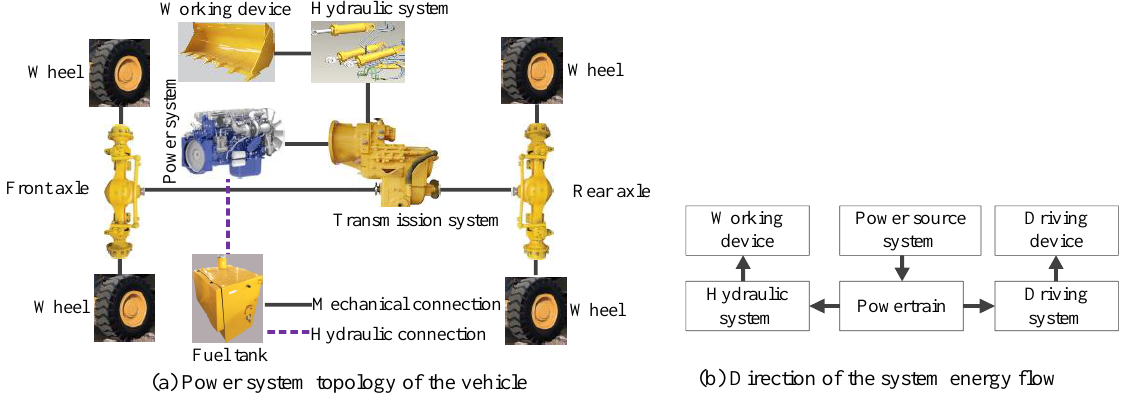
Figure 1. The drivetrain configuration of a traditional loader.